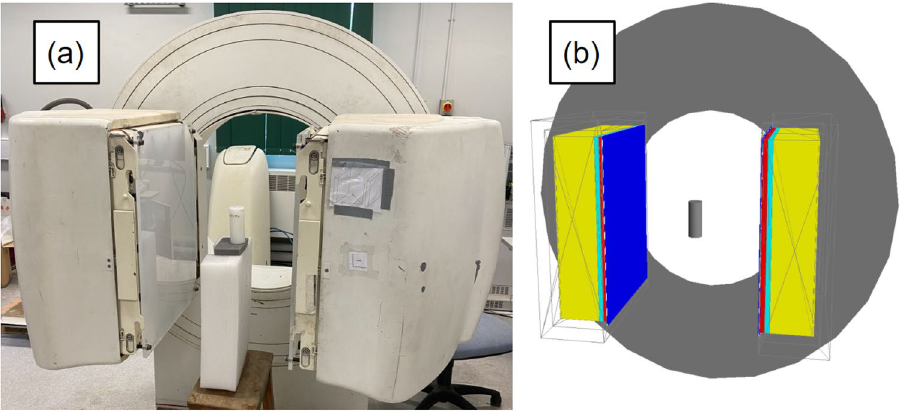
Figure 1. The ADAC Forte at the Positron Imaging Centre during the count-rate experiment ( a ) and the GATE model of the detector and replicated experiment ( b